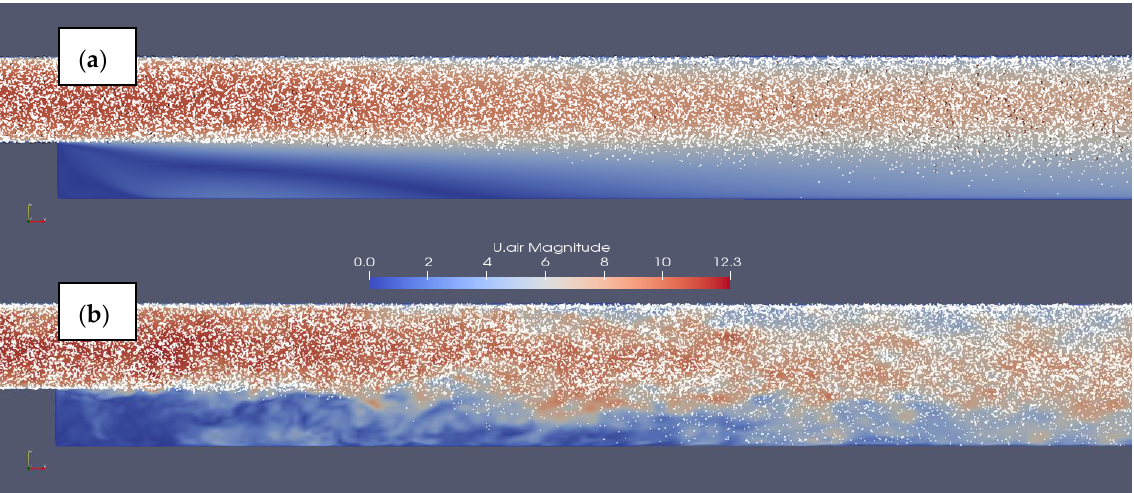
Figure 10. Screenshot showing particle dispersion behind the step at 1 s under ( a ) RANS-DEM and ( b ) LES-DEM frameworks.